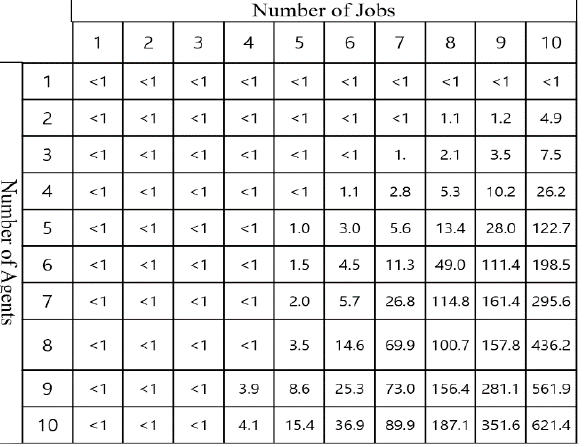
Figure 4. Average generations time [s] for the combinations of the number of workers and jobs for the PDDL solver.